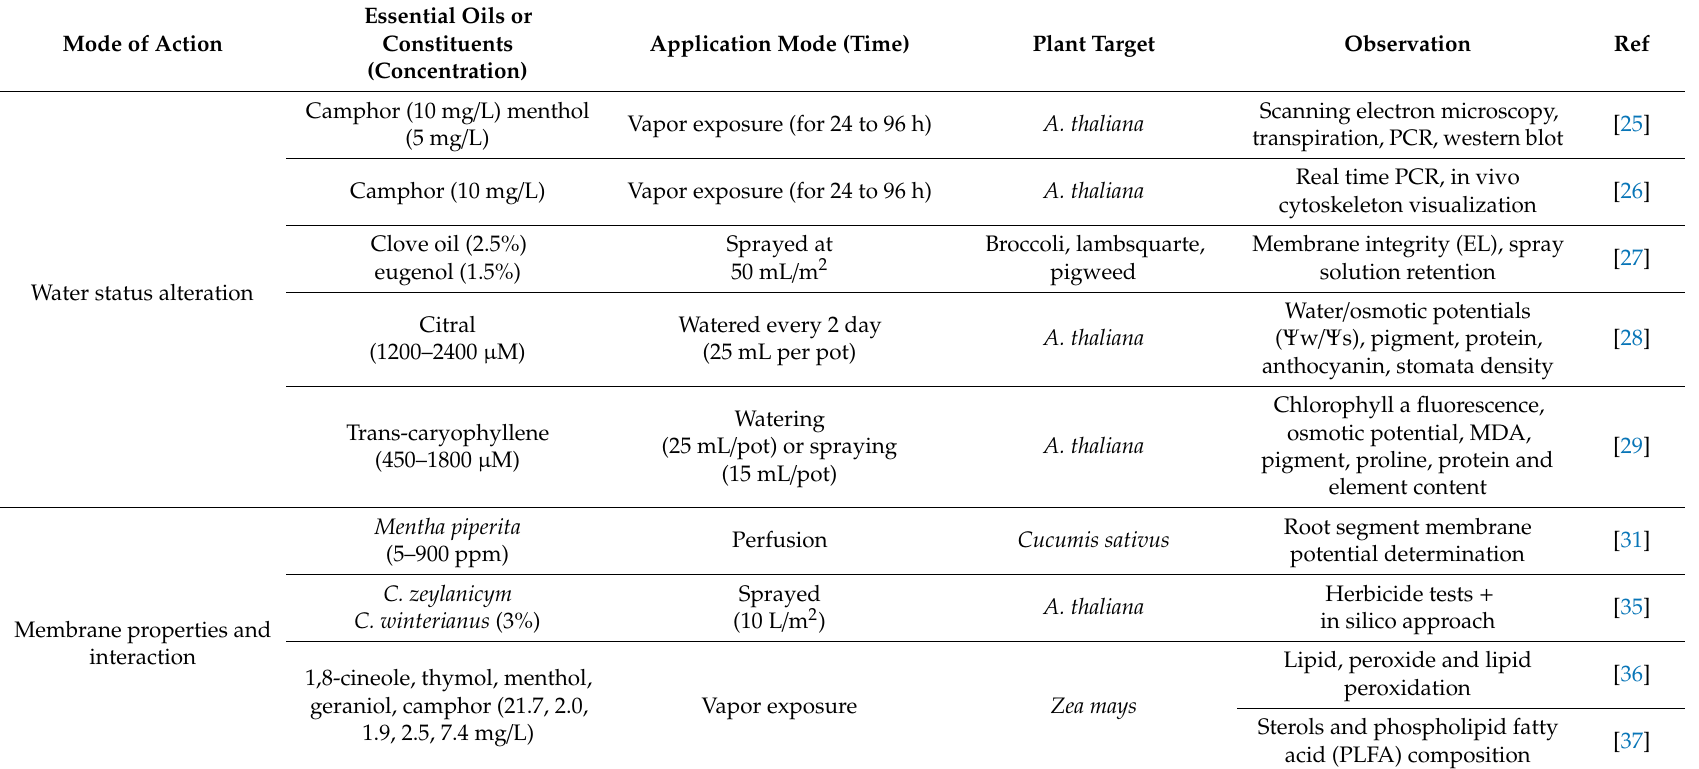
Table 1. Phytotoxic properties of essential oils or constituent solutions in diverse application mode /